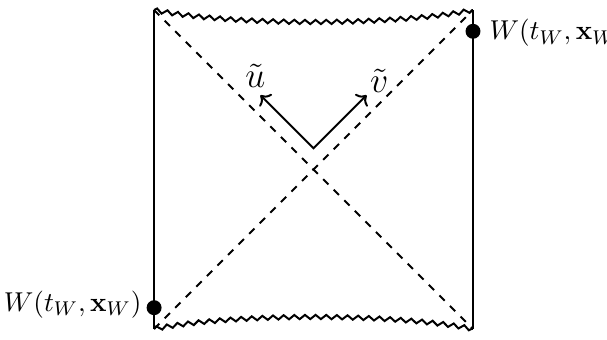
Figure 1 . Penrose diagram of the AdS black hole space-time at x = x W with an appropriate transformation u → ˜ u ( u ) and v → ˜ v ( v ) . See [27] for more details and the definition of ˜ v and ˜ v . Wavy lines are the singularities, dashed lines are the horizons at ˜ u = u = 0 and ˜ v = v = 0 , and vertical lines are the AdS boundaries. In the holographic computations of OTOCs, we usually insert two operators W ( t ) , whose Euclidean times differ by β/ 2 , at the left and right W , x W